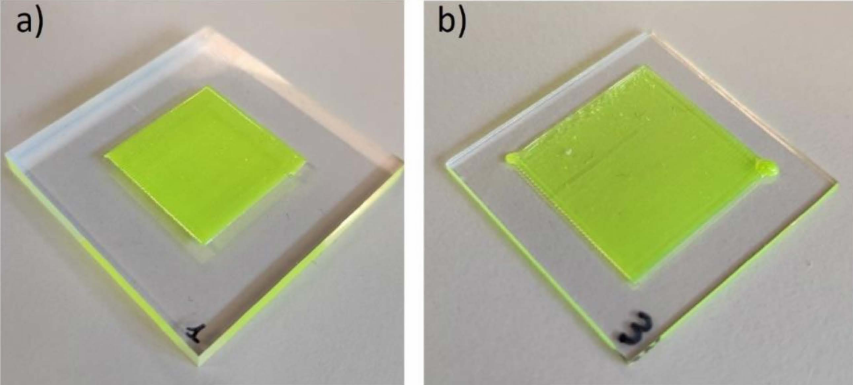
Figure 1. Photographs of printed squares of the LC oligomer containing 0.05 wt% K160 on ( a ) PMMA and ( b )